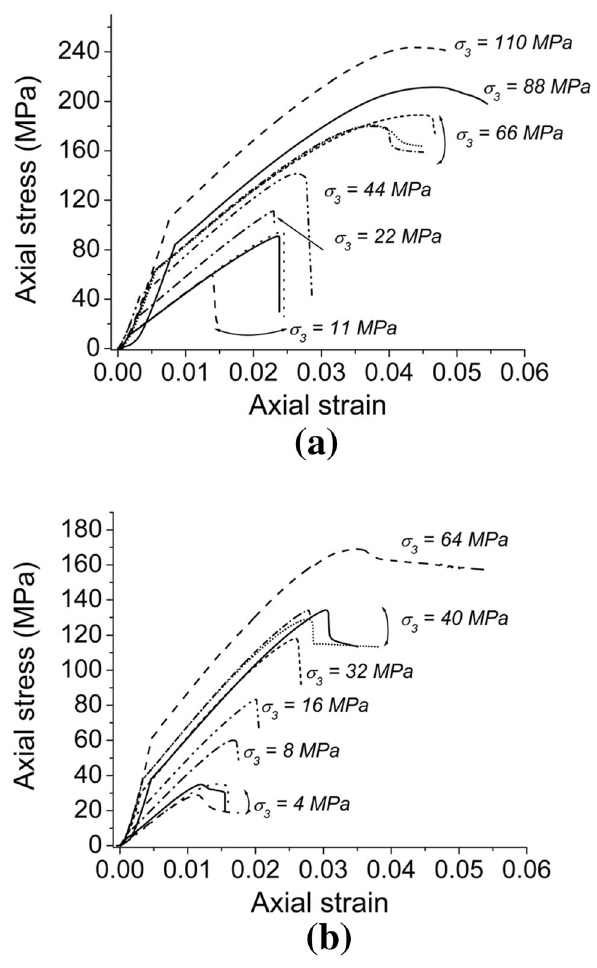
Fig. 5 Complete axial stress–strain curves obtained in triaxial compression tests on the coal at various confining stresses a 0 (cid:3) of the included angle; b 30 (cid:3) of the included